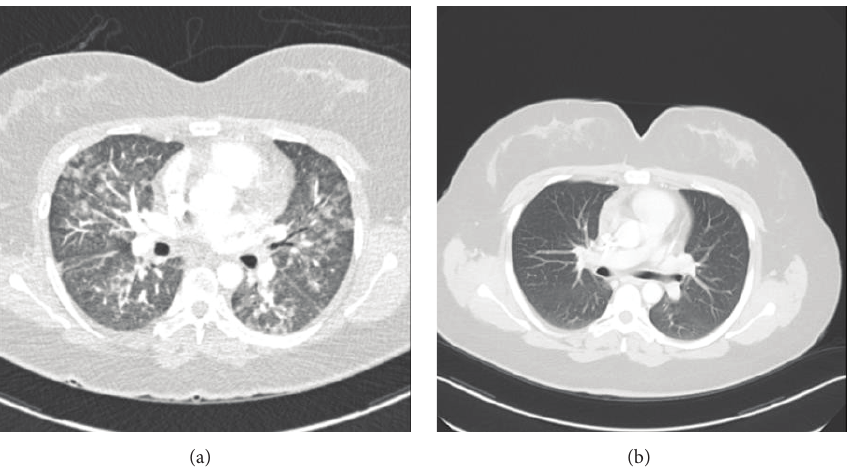
Figure 1: (a) Computed tomography (CT) of the chest showing patchy, nodular ground glass opacities along a bronchovascular distribution throughout both lungs. (b) CT of the chest showing resolution of previously seen opacities after